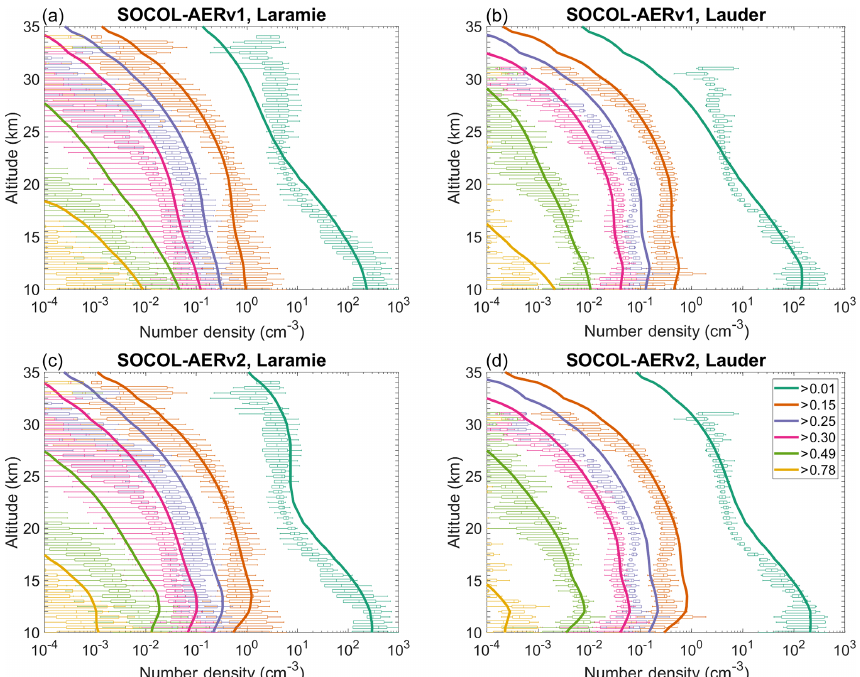
Figure 4. Number densities of particle size bins measured by OPC (Deshler et al., 2003; Deshler, 2008) and modeled by SOCOL-AERv1 and v2 over Laramie, Wyoming, USA (41 ◦ N, 105 ◦ W), and Lauder, New Zealand (45 ◦ S, 170 ◦ W). Measured number densities are shown as box plots (minimum excluding outliers below the 0.4th percentile, 25th percentile, median, 75th percentile, maximum excluding outliers above the 99.6th percentile) and modeled number densities as solid lines. For the Laramie plots (a) , OPC measurements are used from the period 1999–2008 and model results are averaged over the 5 years of the time slice. For the Lauder plots (b) , OPC measurements are used from January to April 1998–2001 and zonal mean model results are averaged from January to April over 5 years of the time slice. Model results are weighted with the counting efficiencies for OPC channels from Deshler et al. (2019) for direct comparability with the